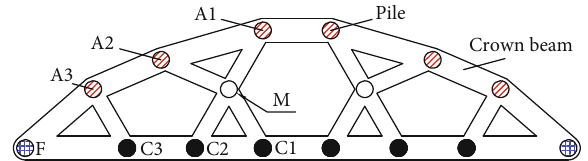
Figure 8: Details of the numbering of